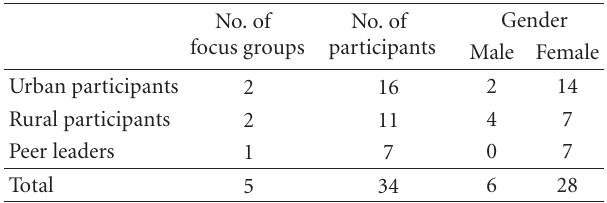
Table 1: Focus group